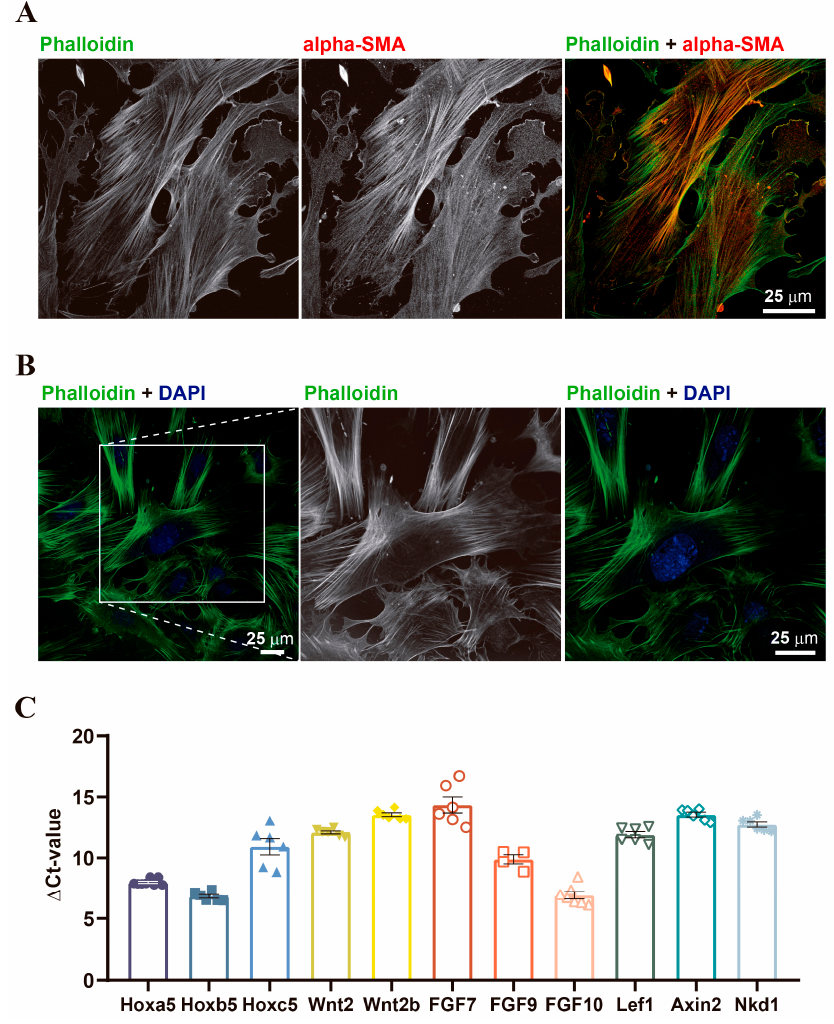
Figure 4. Immunofluorescence staining and RT-qPCRs confirming the purity of the primary lung fibroblast culture. ( A ). Alpha-smooth muscle actin (alpha-SMA) and phalloidin are used as positive markers. Scale bar 25 µm. ( B ). Phalloidin staining with DAPI counterstained nuclei. Scale bars: 25 µm. ( C ). Gene expression in newborn lung fibroblast of specific genes from the Hox-Wnt2-FGF axis.